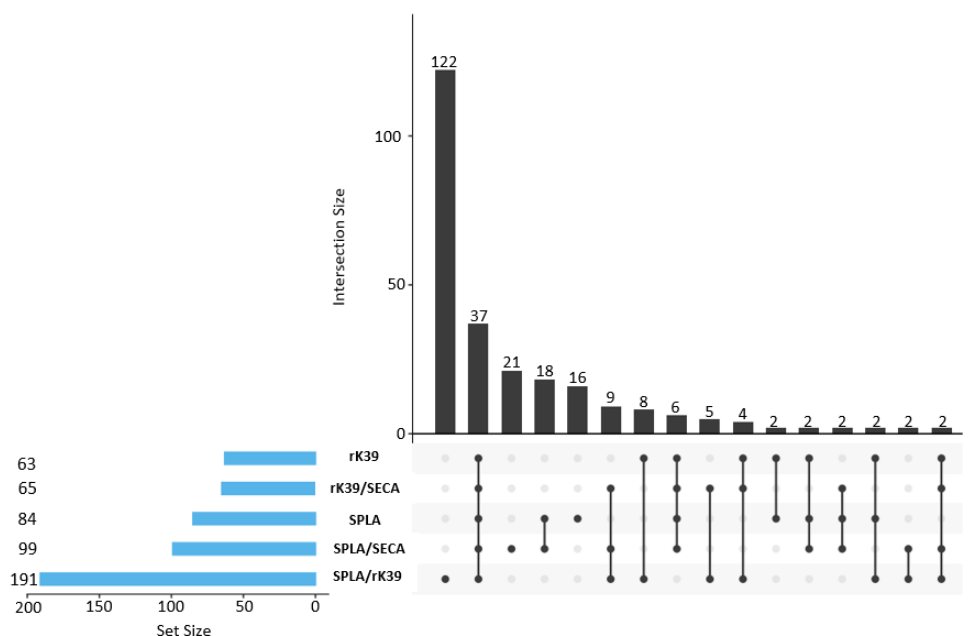
Figure 4. UpSet Plot depicting the positivity intersect to rK39, SPLA, rK39/SECA, SPLA/SECA, and SPLA/rK39 in the PT cohort. The black bars in the graph represent the absolute number of positive events of each intersection, associated with the six parameters evaluated. Under each black bar, the connecting line represents the intersection of the tested parameters. If no intersecting line is present it means that dogs only positive to one event are being quantified in the upper black bar. To the left, the blue bars represent the absolute number of dogs that are positive to each individual characteristic evaluated. In each individual graphic the antigens are ordered by increasing number of seropositive animals.